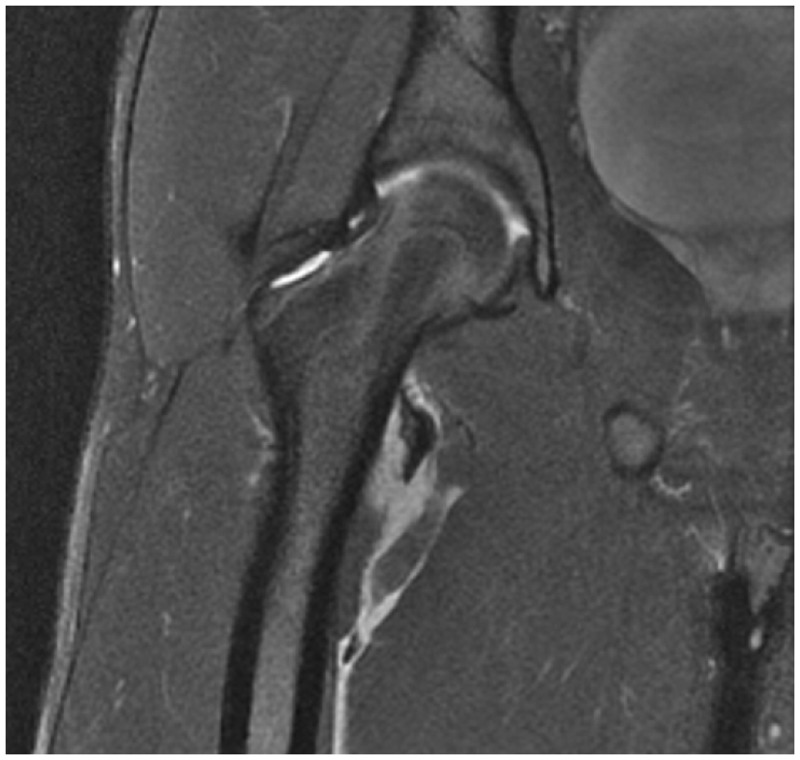
MRI scan showing an avulsion of the right lesser trochanter.